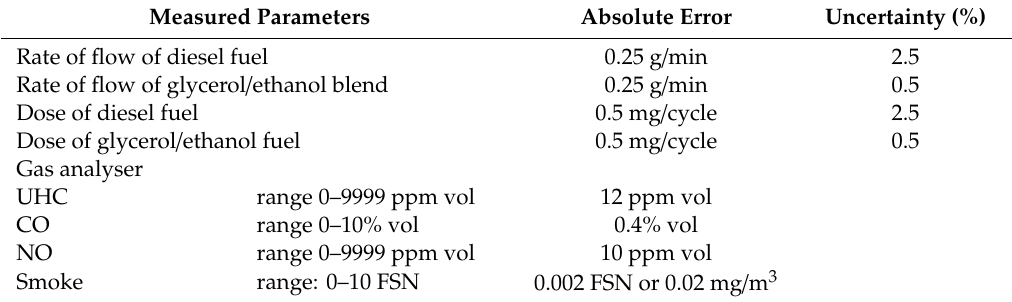
Table 6. Absolute errors and uncertainties of measured